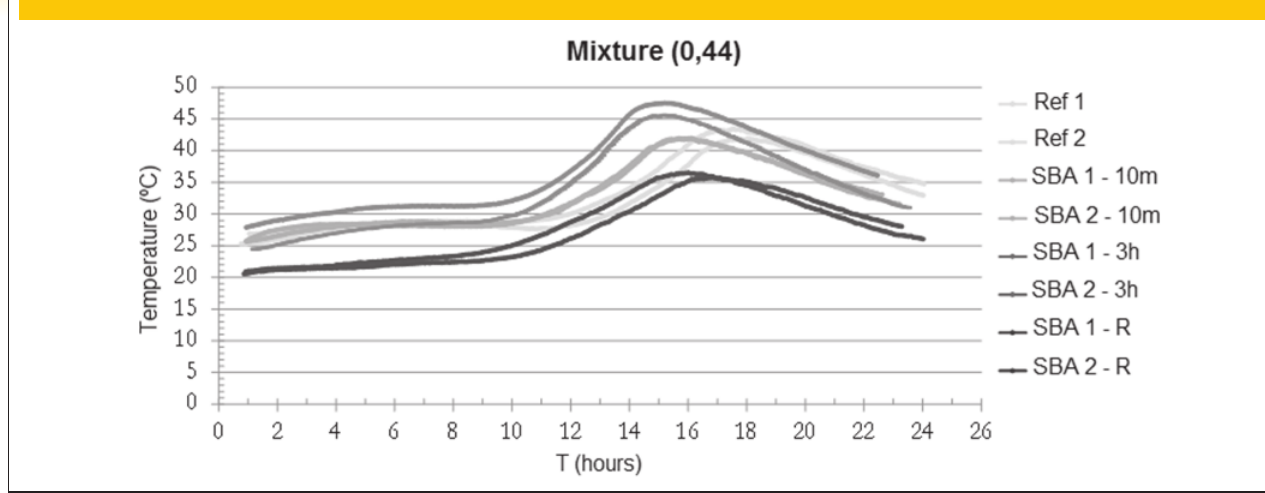
Figure 10 – Temperature history formortar mixtures with w/c = 0.44